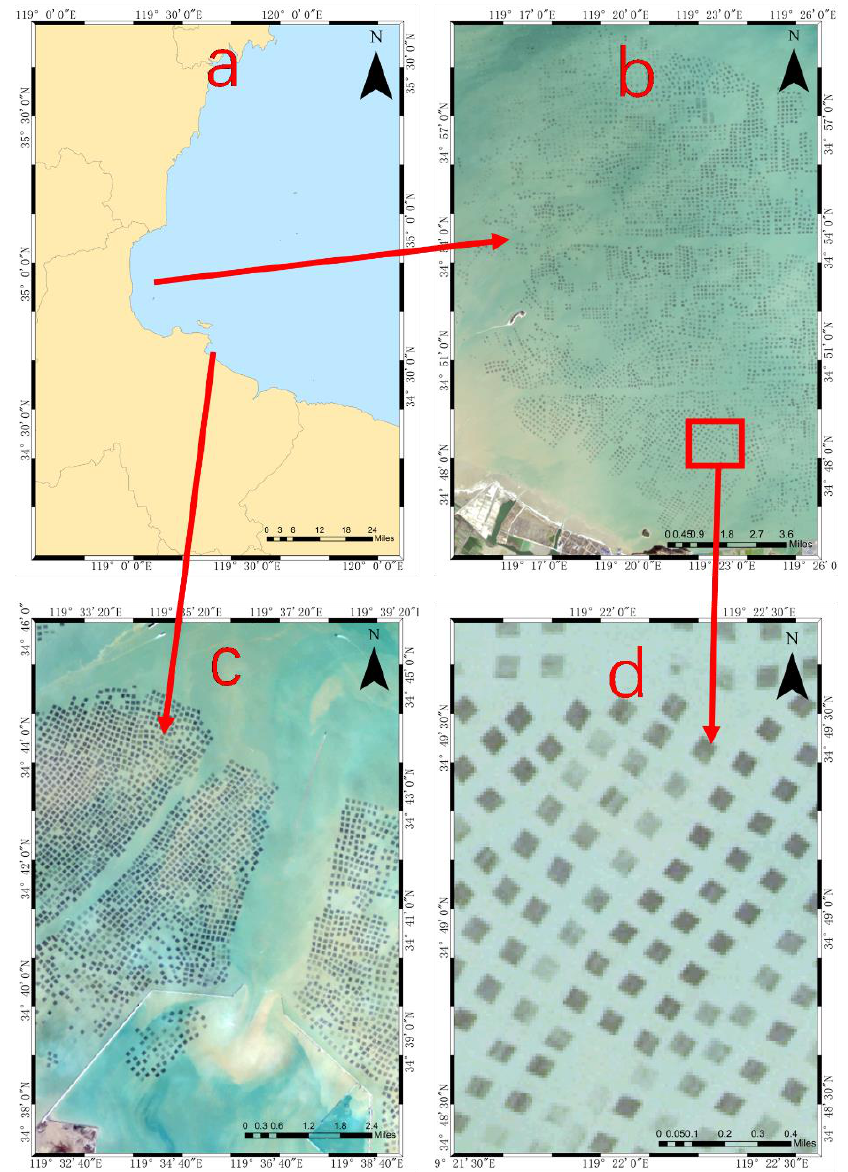
Figure 1. Map of ( a ) the coverage of the experimental area and aerial photographs of the research areas ( b – d ); ( b – c ) images of aquaculture rafts at different locations in Haizhou Bay; ( d ) a local image of the breeding area. Table 1. Introduction to the study